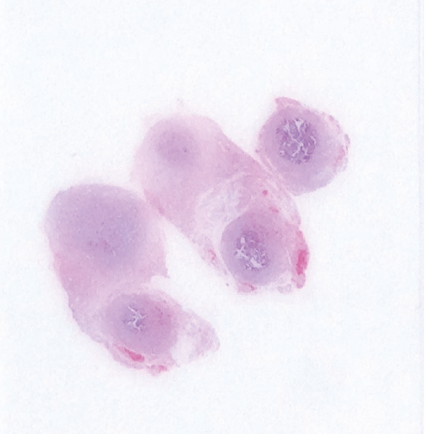
Figure 1: H&E stained cross section of left fallopian tube and adjacent nodule.